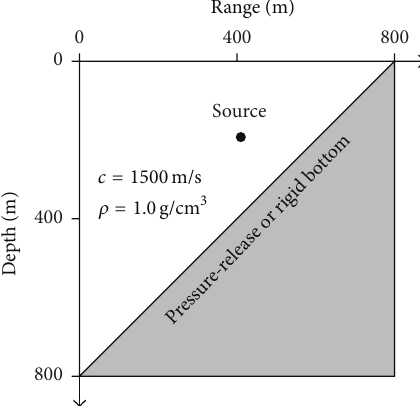
Figure 1: The sketch of the ideal wedge environment used in the numerical experiments. The line source is located at 400 m in range and 200 m in depth. The source frequency is